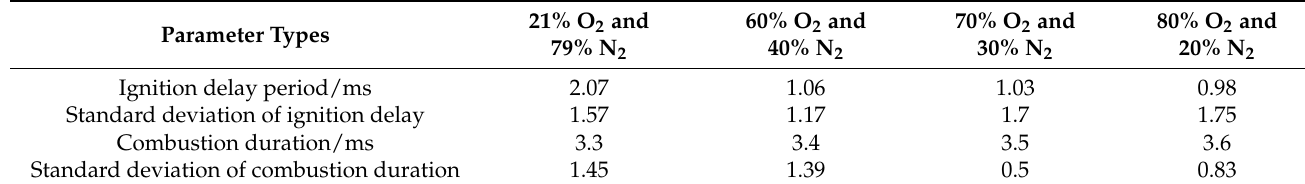
Figure 3. Comparison of the total light intensity and combustion starting position of combustion. Table 1. Comparison of the ignition delay period and duration of constant volume combustion vessels under low-nitrogen conditions.